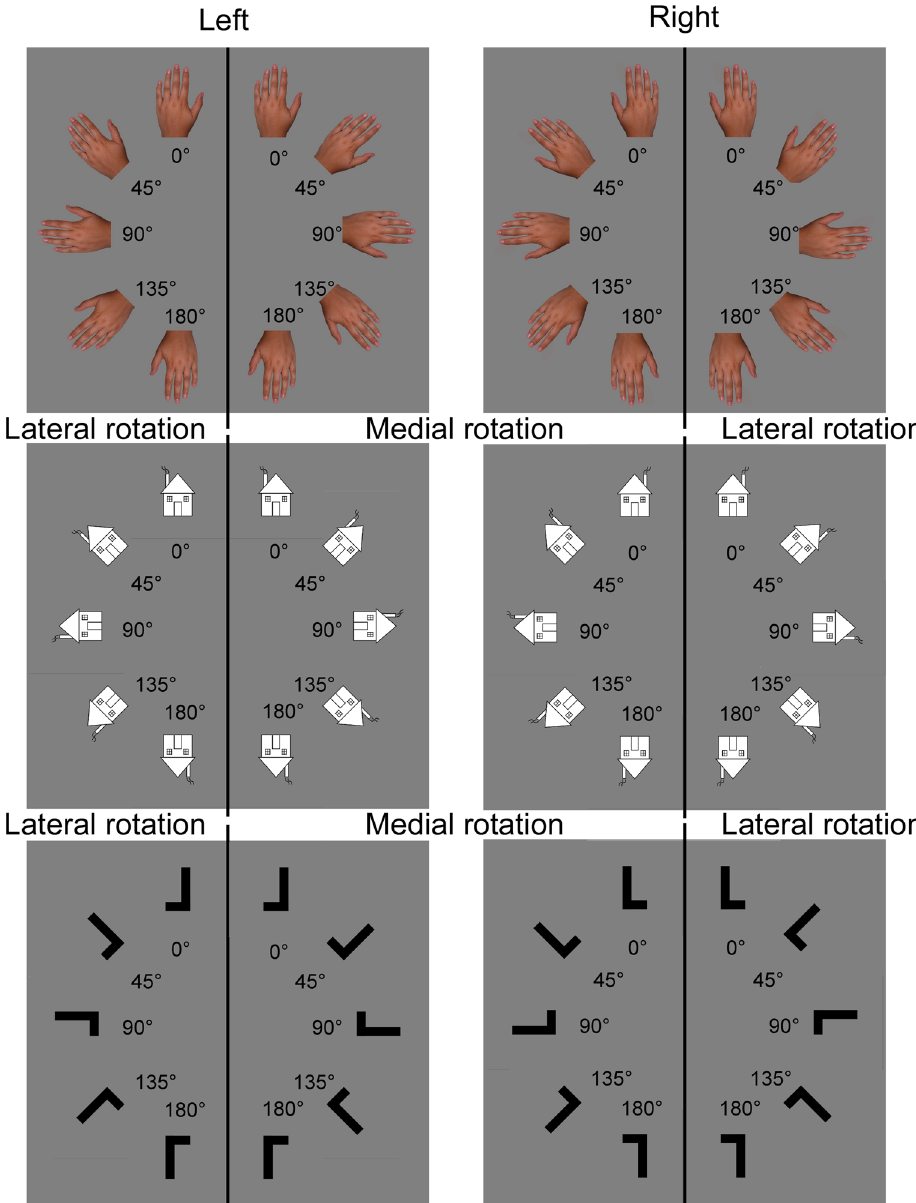
Figure 1. Stimuli of the mental imagery task. Stimuli result from the combination of stimulus type (hand, house or letter), laterality (left or right), rotation (medial or lateral) and orientation (0°, 45°, 90°, 135° or 180°). For pictures of hands, clockwise rotations of the left hand and anticlockwise rotations of the right hand correspond to medial rotations. Anticlockwise rotations of the left hand and clockwise rotations of the right hand correspond to lateral rotations. For the purpose of statistical analyses, rotation conditions of the house and letter images were relabeled in order to match conditions and the response codes of the hand pictures. Accordingly, for images of houses with a right-sided chimney and the L with the horizontal bar at the right, clockwise rotations are considered as lateral rotations and anticlockwise rotations as medial rotations. The reverse is the case for images of houses with a left-sided chimney and the L with the horizontal bar at the